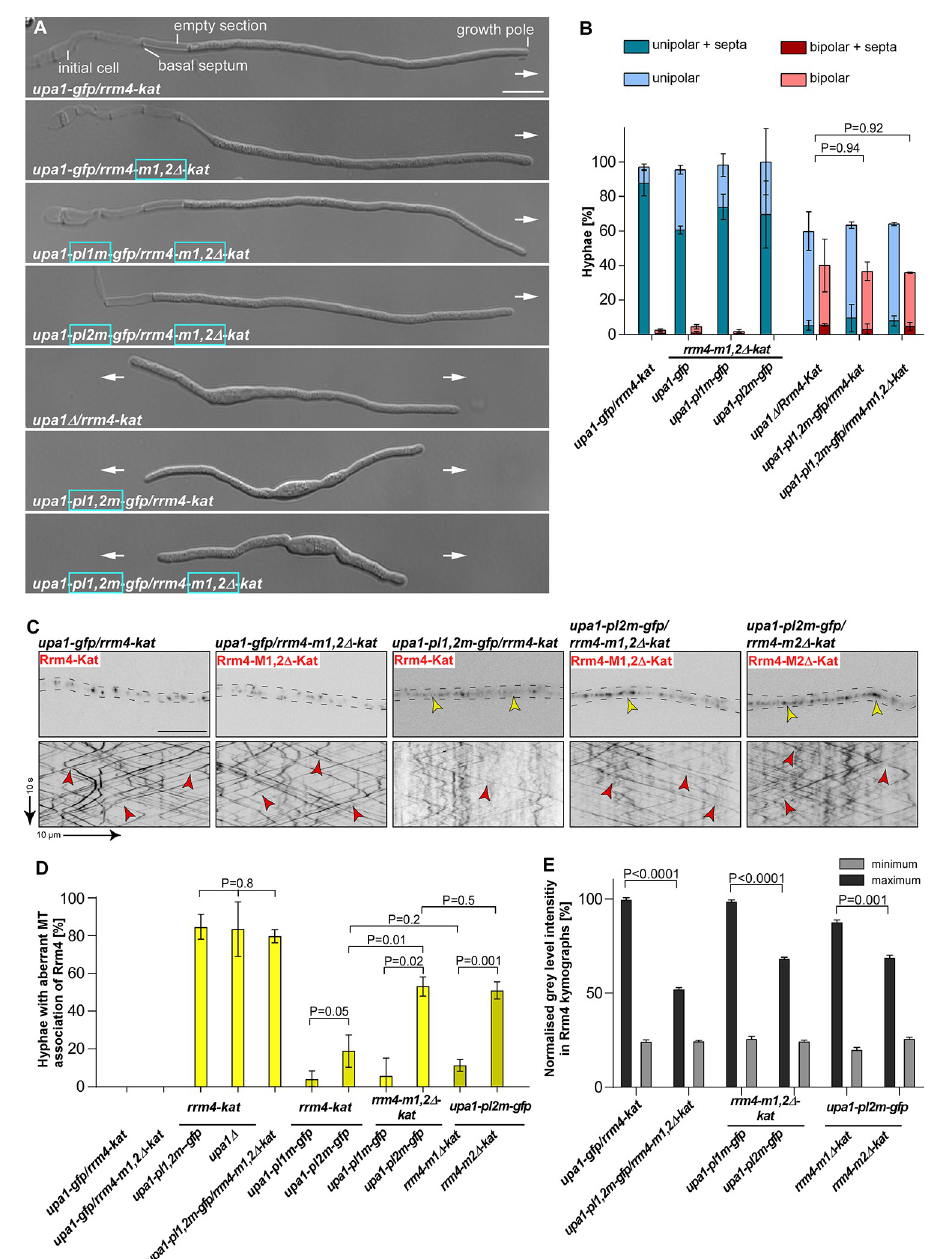
Fig 5. MLLE2 plays an accessory role in endosomal attachment of Rrm4. ( A ) Growth of AB33 derivatives in their hyphal form (6 h.p.i.; size bar 10 μ m). Growth direction is marked by arrows. ( B ). Quantification of hyphal growth of AB33 derivatives shown in A (6 h.p.i.): unipolarity, bipolarity and basal septum formation were quantified (error bars, SEM; n = 3 independent experiments, > 100 hyphae were analysed per strain; For statistical analysis, the percentage of uni- and bipolarity was investigated by using unpaired two-tailed Student’s t-test ( α < 0.05). ( C ) Micrographs (inverted fluorescence image; size bar, 10 μ m) and corresponding kymographs of AB33 hyphae derivatives (6 h.p.i.) co- expressing various Upa1-Gfp and Rrm4-Kat versions as indicated. Movement of Rrm4-Kat versions is shown (arrow length on the left and bottom indicates time and distance, respectively). Bidirectional movement is visible as diagonal lines (red arrowheads). Aberrant microtubule staining is indicated by a yellow arrowhead. ( D ) Percentage of hyphae (6 h.p.i.) exhibiting aberrant microtubule association as indicated in panel C and S8C Fig. Set of strains that were analysed simultaneously are shown in the same yellow shading (error bars, SEM; for statistical evaluation, the percentage of hyphae with abnormal microtubule staining was compared by using unpaired two-tailed Student’s t-test ( α < 0.05); n = 3 independent experiments, > 25 hyphae were analysed per strain). ( E ) Normalised minimum and maximum grey level intensities of shuttling signals measured in Rrm4 kymographs showed in Figs 5C and S5C (error bars, SEM; n = 3 independent experiments, 100 shuttling signals kymographs were analysed per strain, two-tailed Student’s t-test ( α > 0.05).